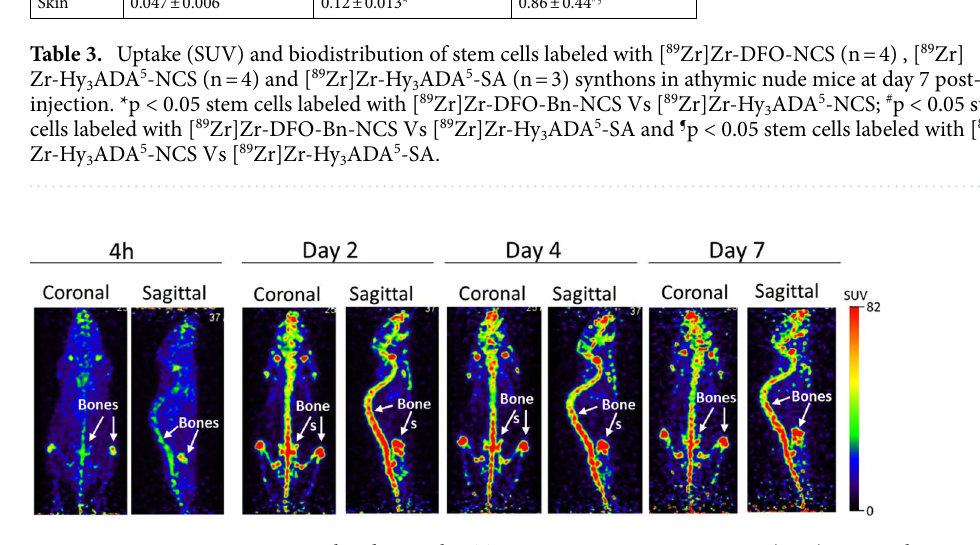
Figure 11. Representative coronal and sagittal PET maximum intensity projection (MIP) images showing distribution of [ 89 Zr]ZrCl 4 in athymic nude mice at different time points post-injection.